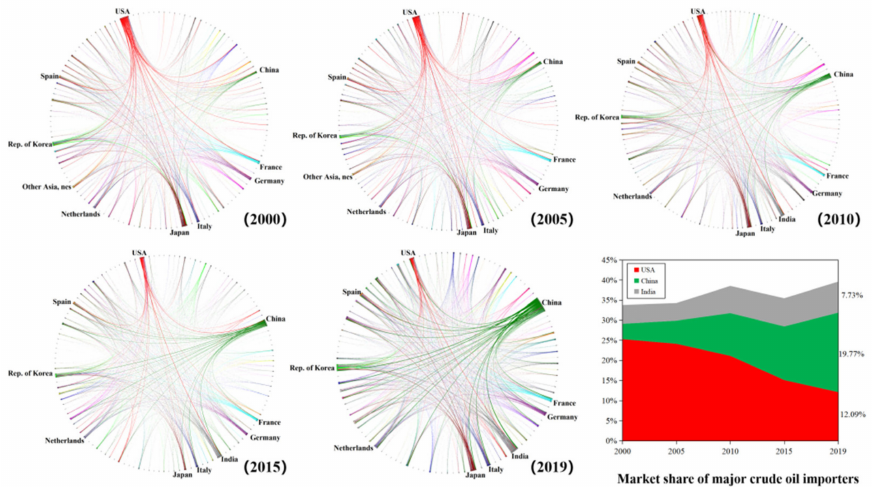
Figure 3. The evolution of competition among importers from 2000 to